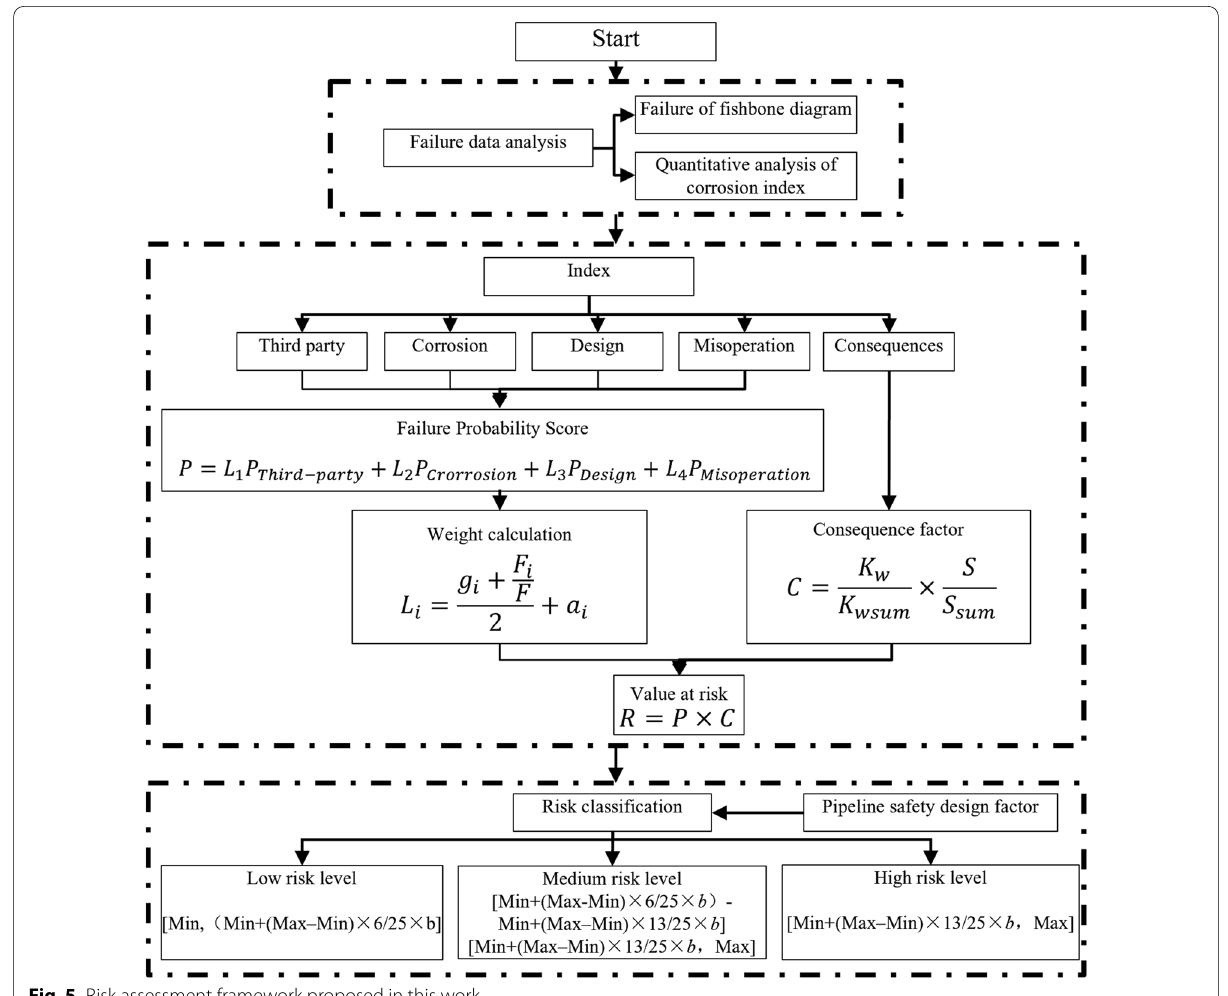
Fig. 5 Risk assessment framework proposed in this